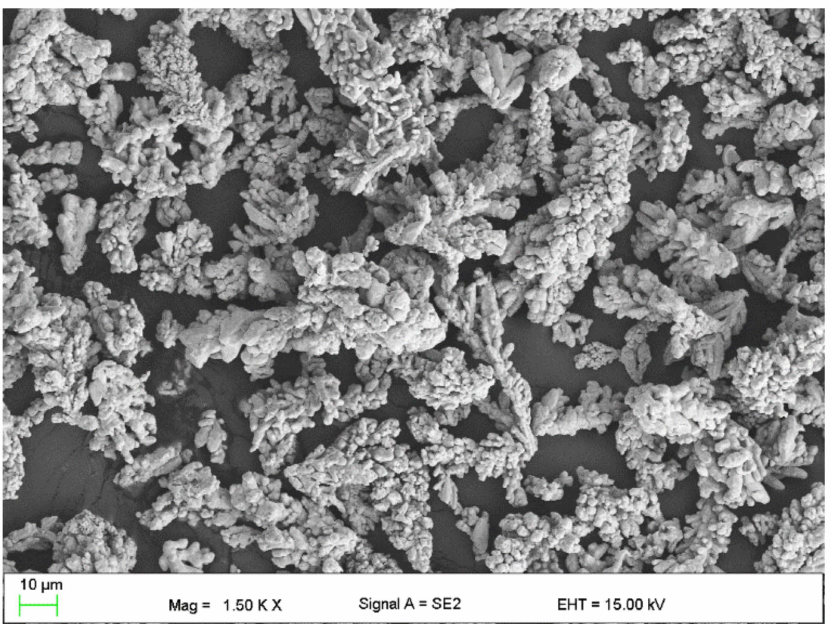
Figure 4. Copper powder LT16.